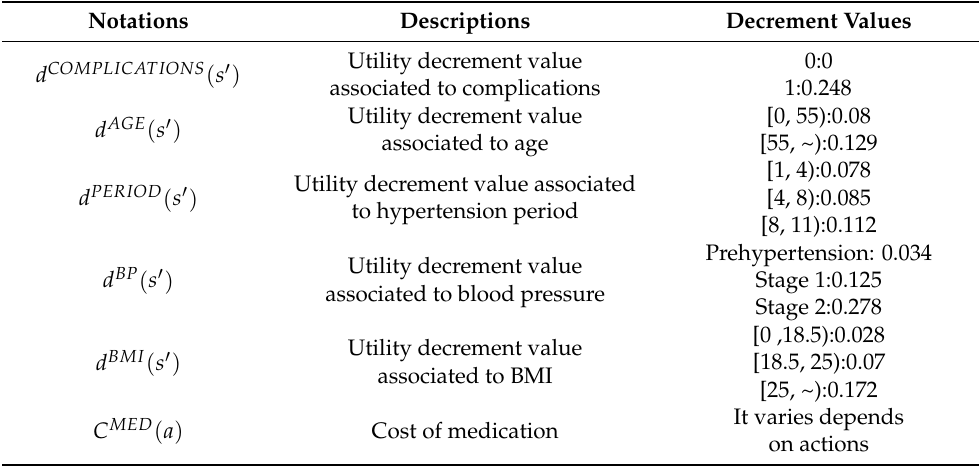
Table 5. Reward value descriptions.